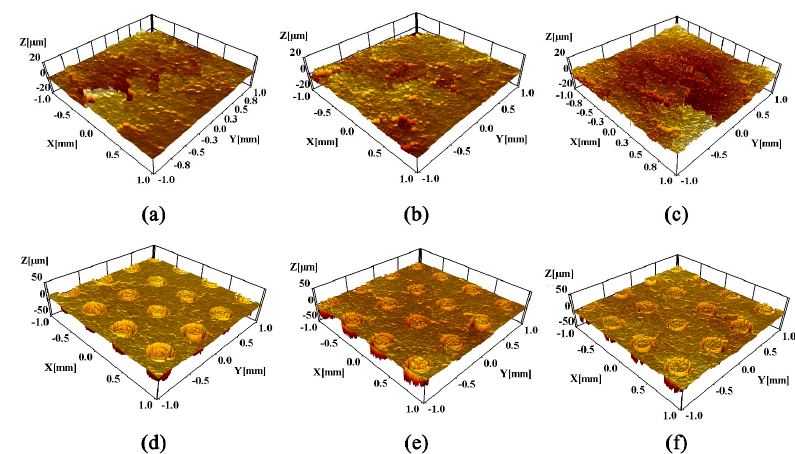
Figure 3. Three-dimensional morphology of titanium alloy samples after nitriding and nitriding/texturing combined treatment at ( a , d ) 750 °C, ( b , e ) 850 °C, ( c , f ) 950 °C.